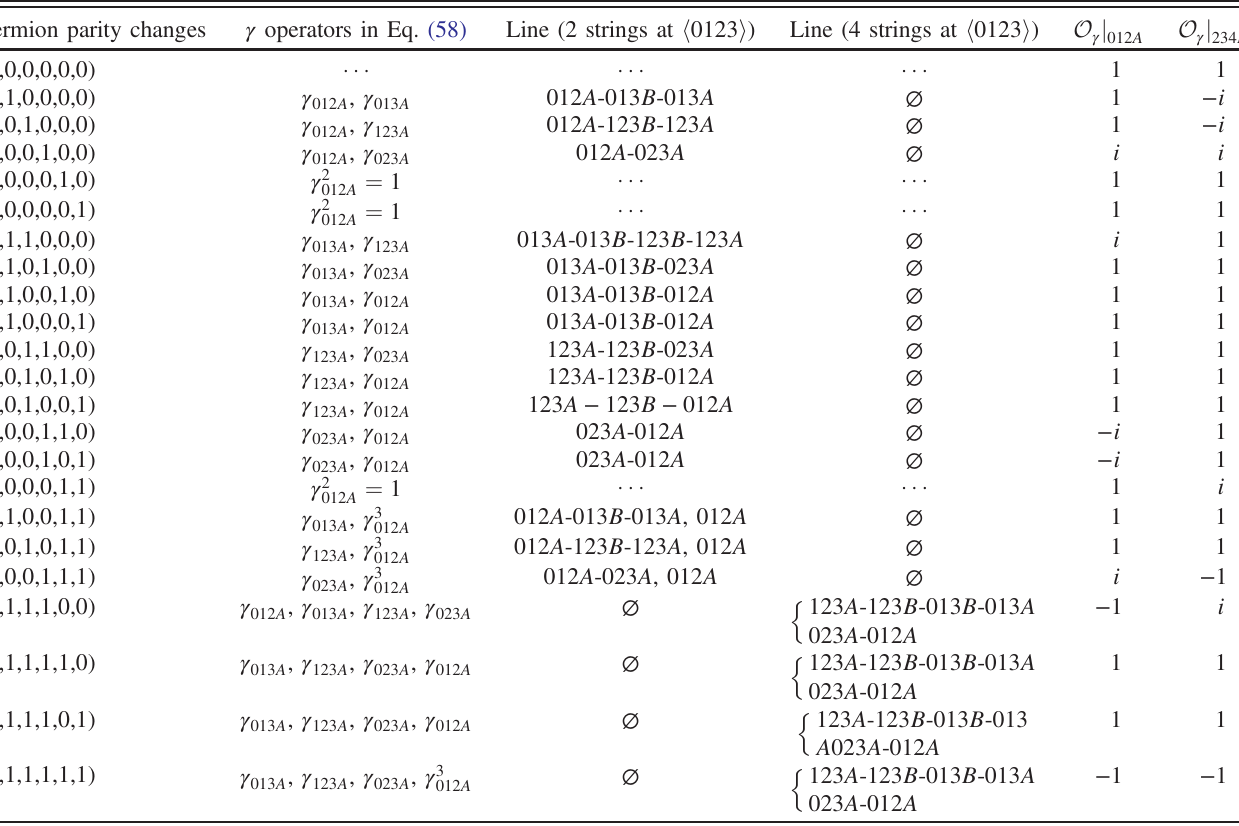
; g ; g that have two or four strings at tetrahedron h 0123 i ]. The last two i j k Þ ; g ; g belonging to this row [the last column but one uses the convention γ 012 in Eq. (43), and i j k Þ A ]. Nontrivial results are labeled in red or blue. The results in this table can be summarized to the B and in Eq. (61) for convention γ 234 A B